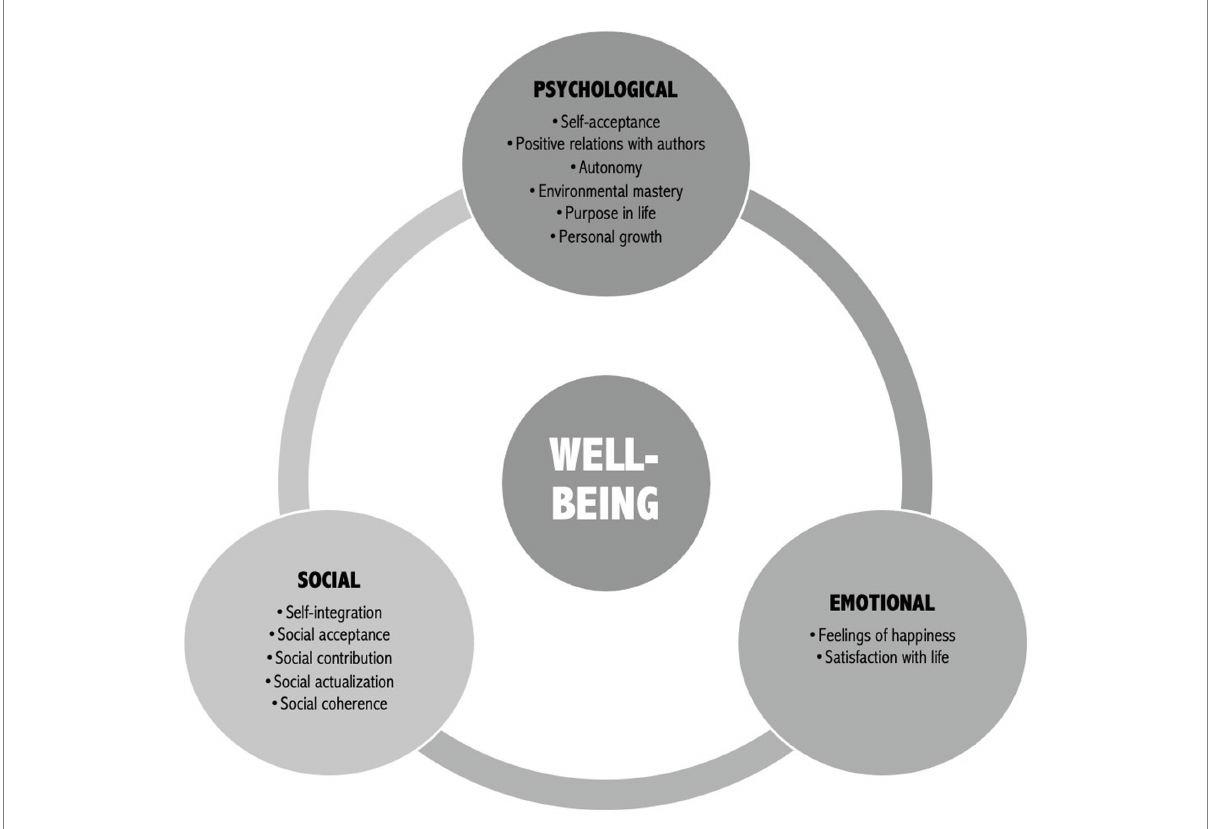
FIGURE 1 Dimension of psychological, emotional, and social well-being (Data extracted from Westerhof and Keyes,